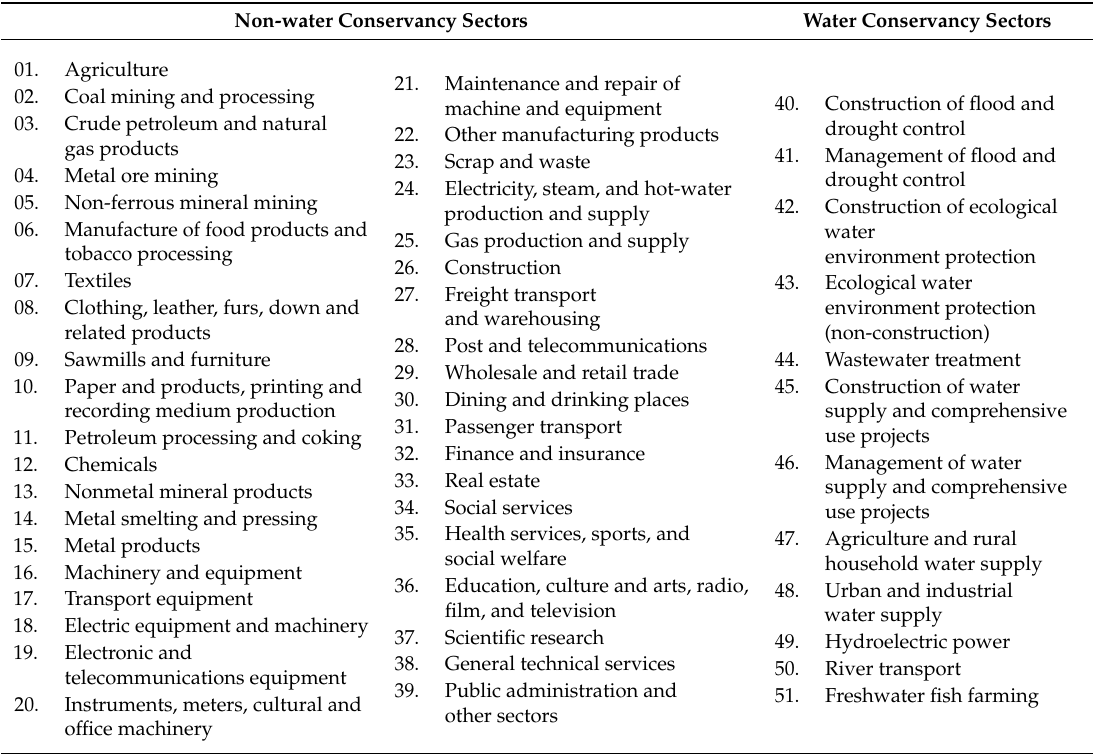
Table A2. Names and classifications of the 51 sectors.